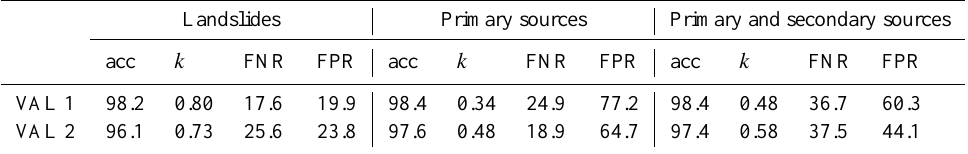
Table 3. Accuracy measures for landslide recognition (landslide-against-all classifier) and separation of landslide source and run-out (source- against-all classifier), for different validation regions (VAL 1 and VAL 2). Two cases are distinguished, depending on whether reference data source areas are primary sources only or include secondary sources (seemingly fresh slides occurring inside the run-out area).